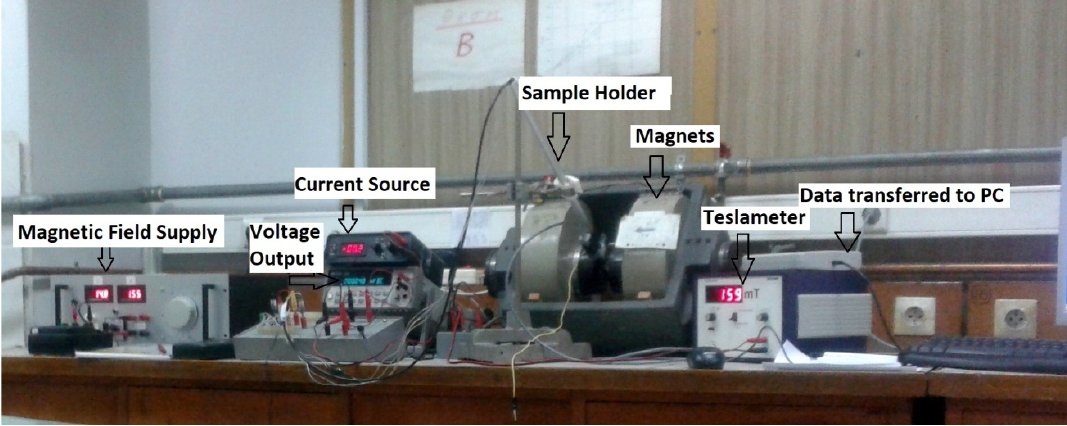
Figure A2. van der Pauw and Hall coefficient measurement setup.